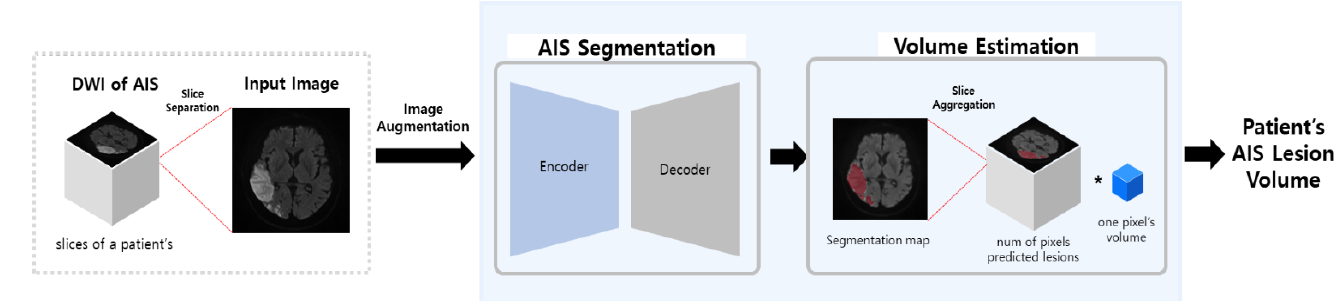
Figure 2. Flowchart of our proposed method .